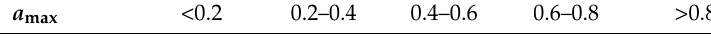
Table 3. Classification of the peak ground acceleration ( a max ) categories.